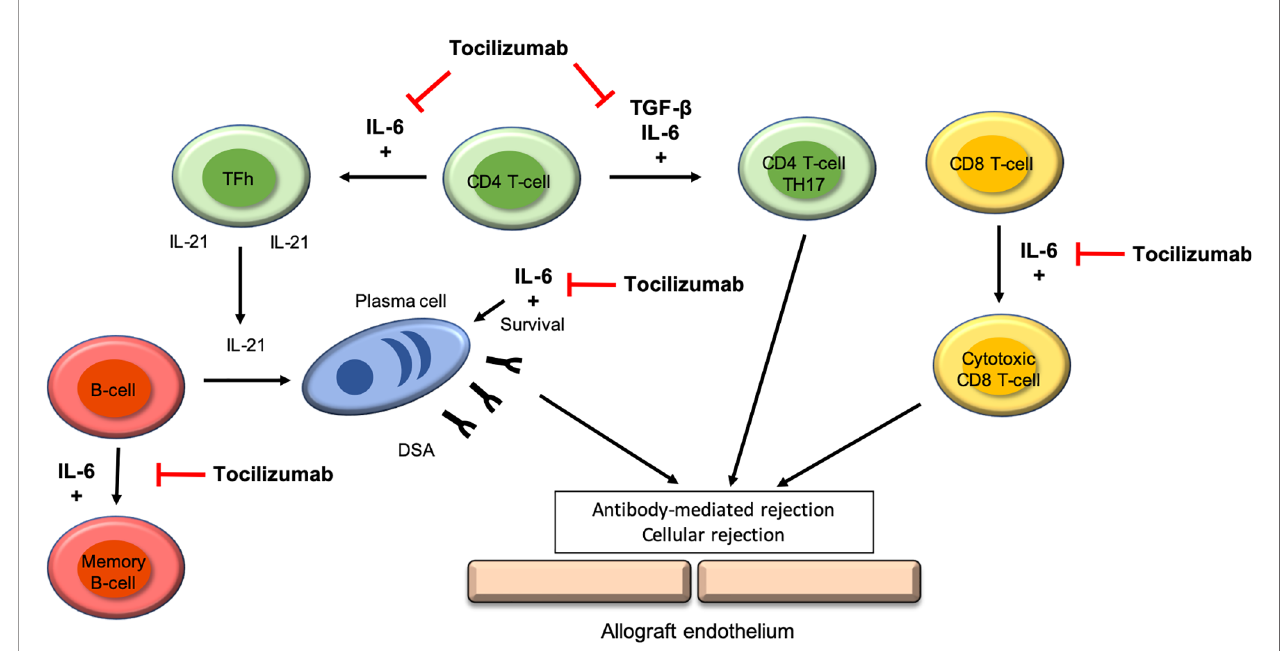
FIGURE 1 | IL-6 receptor targets of Tocilizumab in the development if antibody-mediated